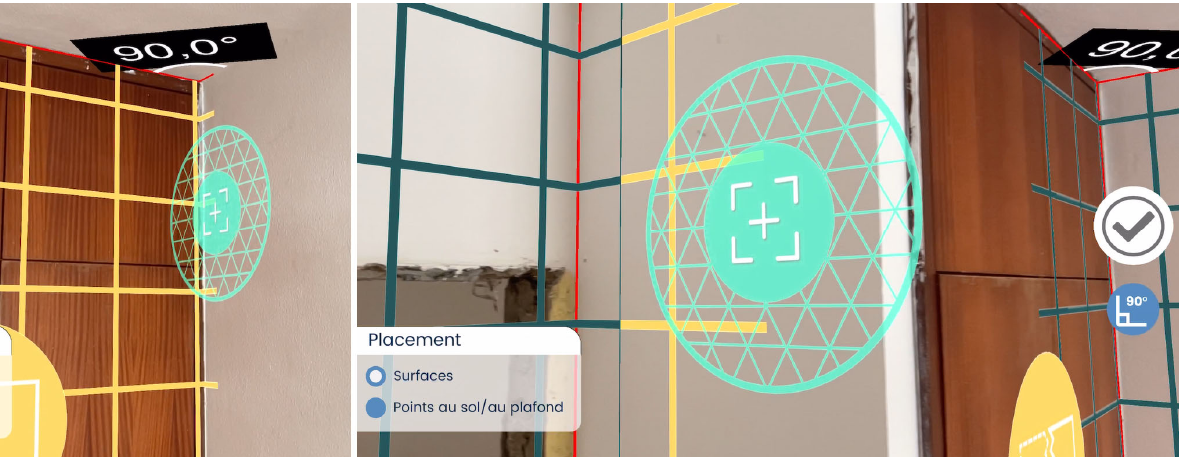
Figure 2. Scan-to-BIM process. Screen capture of wall scanning using iPad and BIMeo software Figure 2. Scan ‐ to ‐ BIM process. Screen capture of wall scanning using iPad and BIMeo software [93].